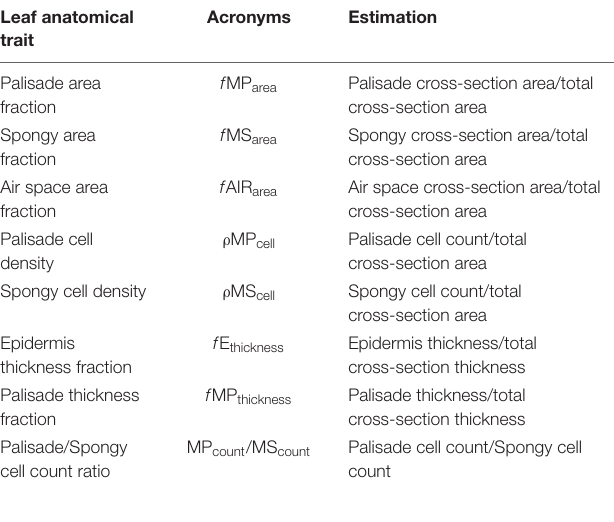
TABLE 3 | Description of the leaf anatomical traits. Leaf anatomical